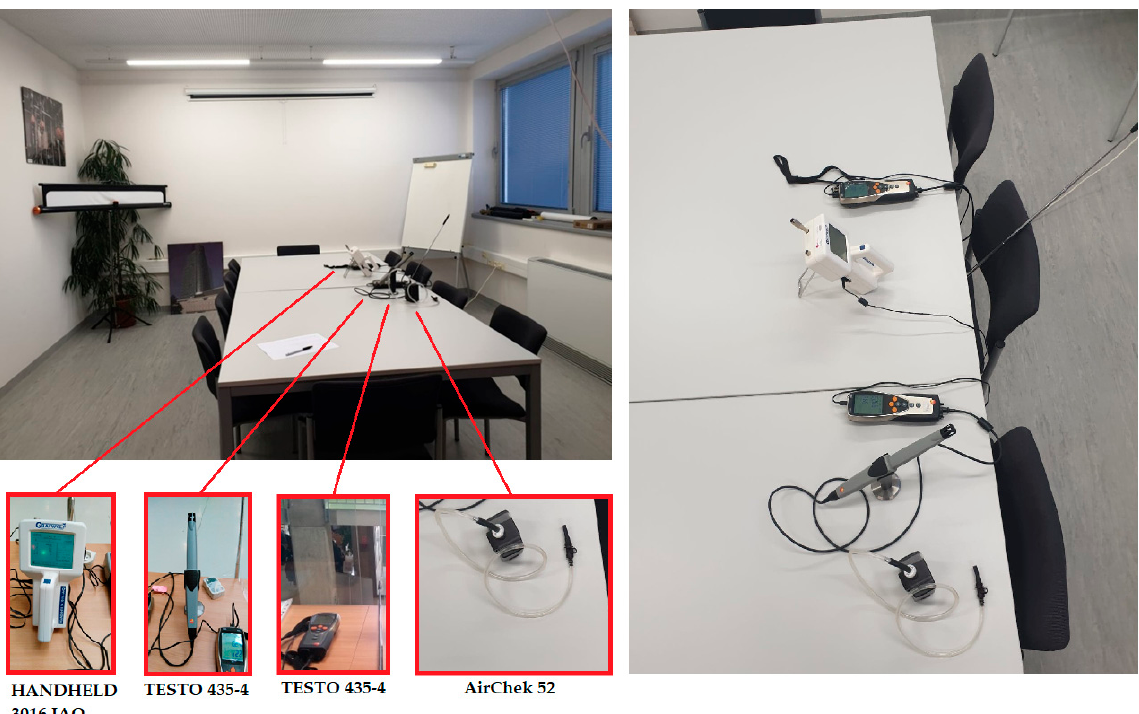
Figure 5. Monitored room with the measuring instruments. From 11th February 2020 to 24th February 2020, the indoor environmental